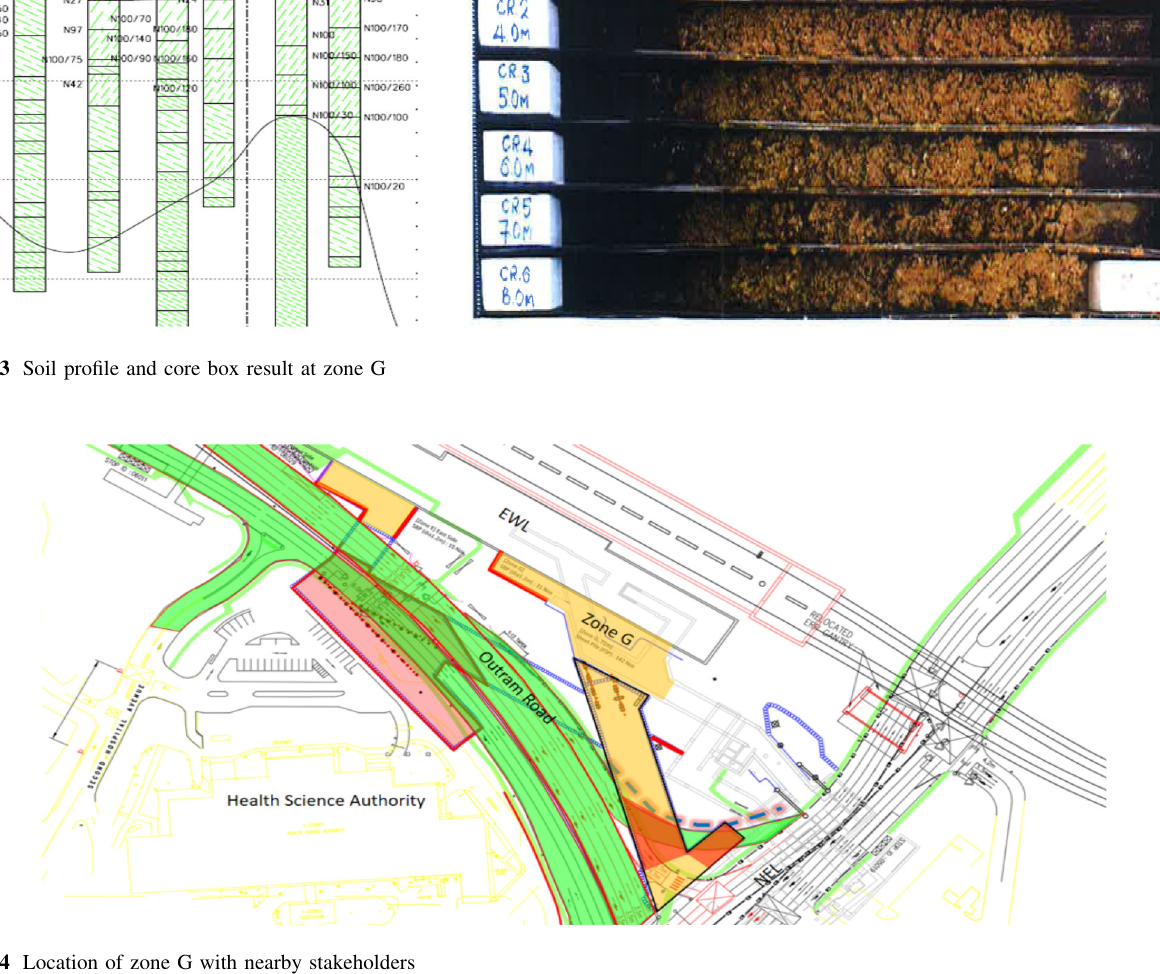
Fig. 4 Location of zone G with nearby stakeholders